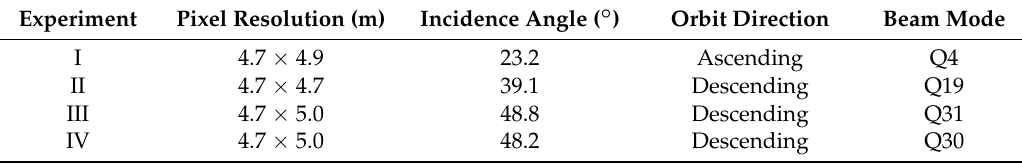
Table 1. Parameters of Radarsat-2 single-look fully polarimetric (FP) images in four experiments.